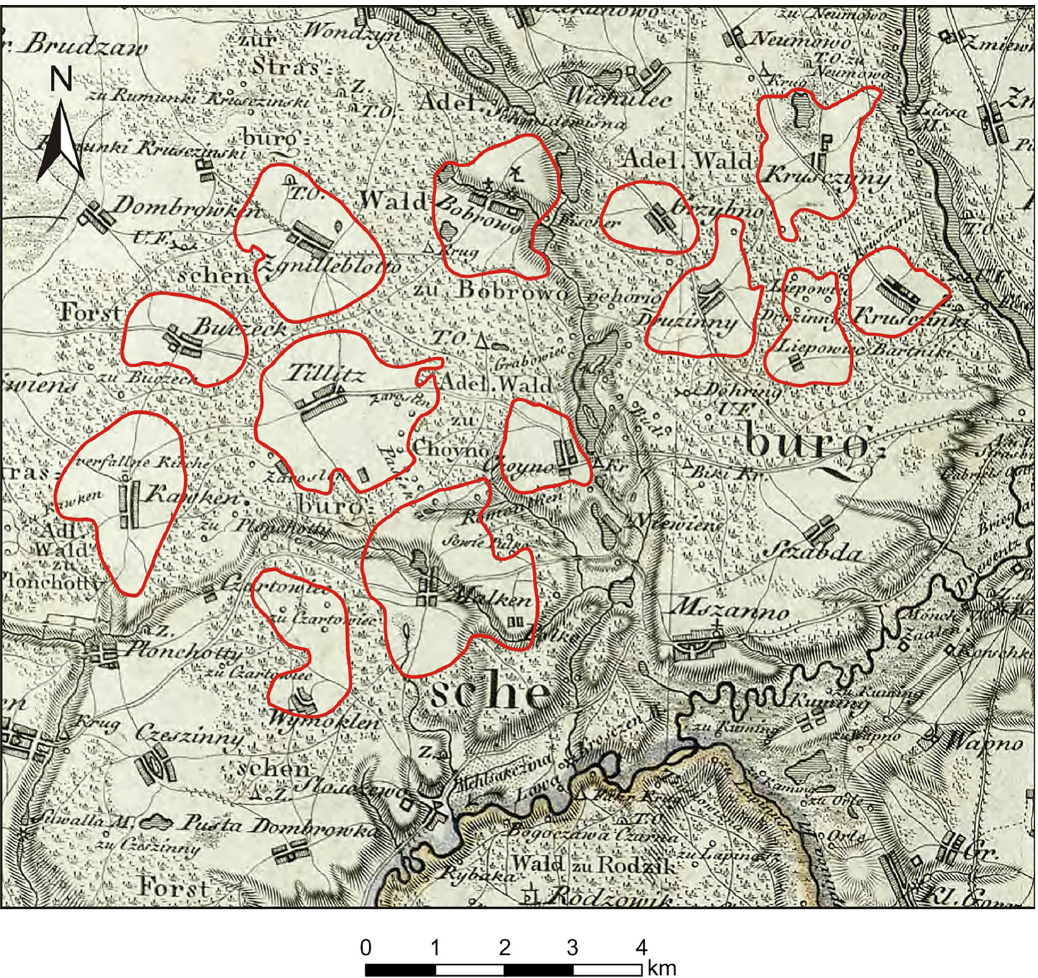
Fig. 6. Deforested areas around settlements in the eastern part of Chełmno Land on the Schrötter map from